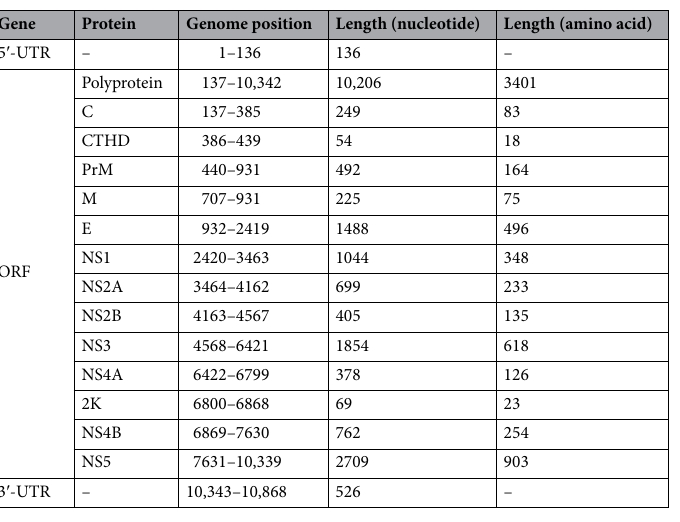
Table 1. Genome organization of Mpulungu flavivirus. The immature C protein consists of mature virion C and a C-terminal hydrophobic domain. The precursor membrane protein undergoes cleavage by protease, resulting in a mature virion. UTR untranslated region, ORF open reading frame, C mature virion C, CTHD C-terminal hydrophobic domain, prM precursor of membrane protein, M membrane protein, E envelope protein, NS non-structural